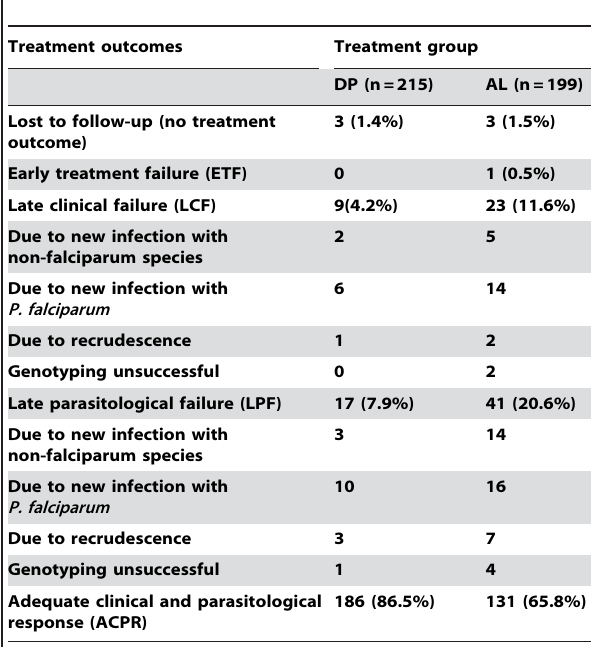
Table 2. WHO treatment outcomes after 42 days of follow-up